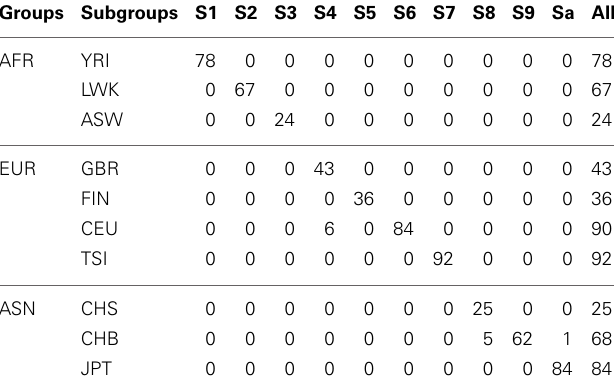
Table 7 | The numbers of subjects assigned to each of the 10 clusters based on the top 10 PCs using our new SSSC algorithm ( α = ˆ α , β = ˆ β ) with SSR =